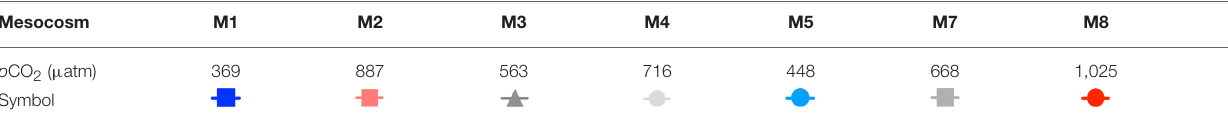
TABLE 1 | p CO 2 treatment of mesocosms (average over the study period), as well as symbols and color-code for figures. Mesocosm